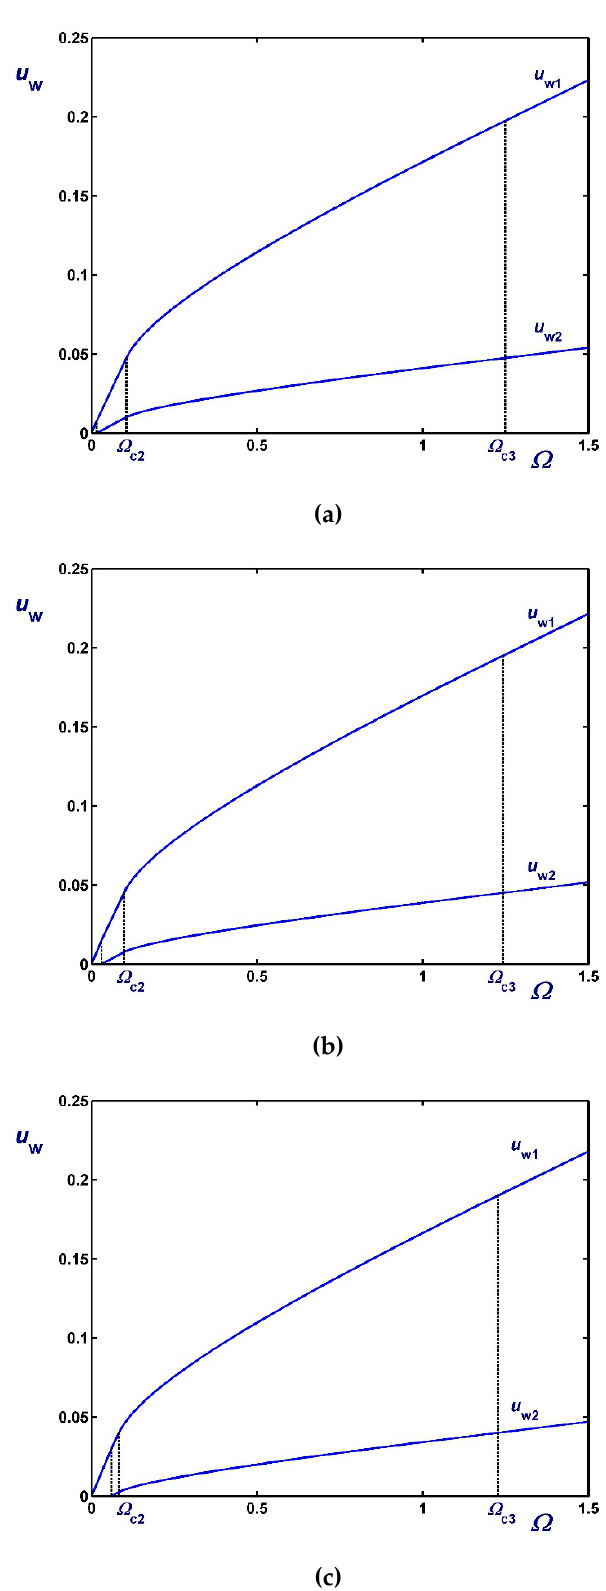
κ= = Figure 16. Slip velocities for κ = 0.5, B = 0.1 and di ff erent values of the dimensionless slip yield stress Figure 16. Slip velocities for 0.5 , 0.1 B and different values of the dimensionless slip number: ( a ) τ c = 0.05; ( b ) τ c = 0.1; ( c ) τ c = yield stress number: ( a )